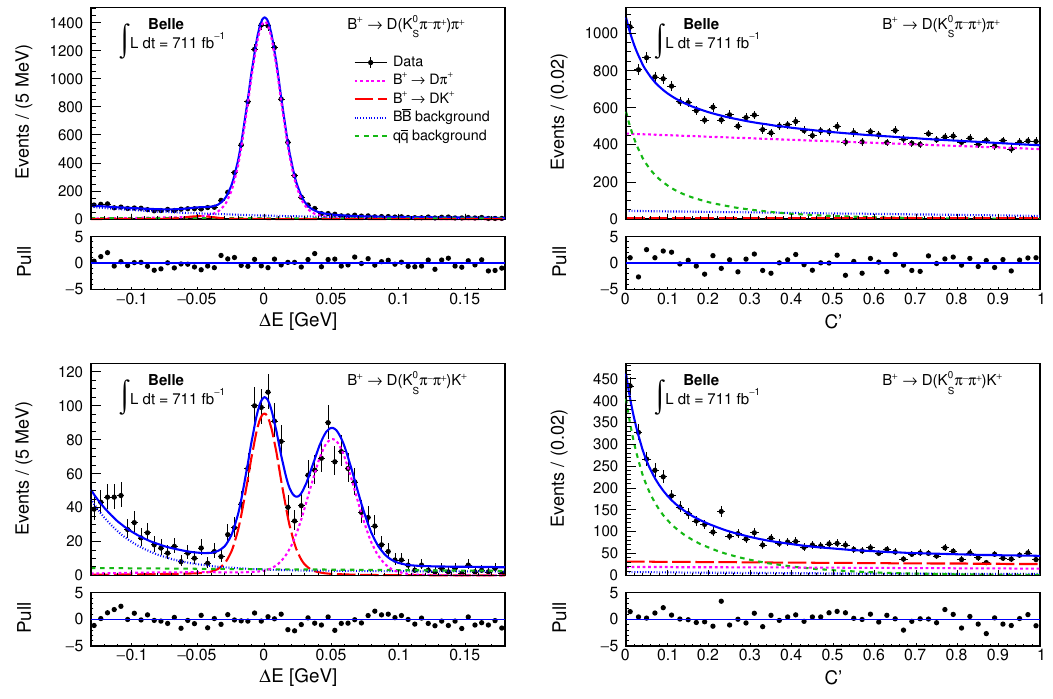
Figure 2 . Distributions of (left) ∆ E and (right) C 0 for (top) B + → D ( K 0 B + → D ( K 0 π − π + ) K + candidates restricted to the signal-enhanced region in the Belle data set with S fit projections overlaid. The black points with error bars represent data and the solid blue curve is the total fit. The large-dotted magenta, long-dashed red, small-dotted blue and short-dashed green curves represent B + → Dπ + , B + → DK + , q ¯ q and combinatorial B ¯ B background components, respectively. Differences between the fit function and data normalised by the uncertainty in data (pull) are shown under each